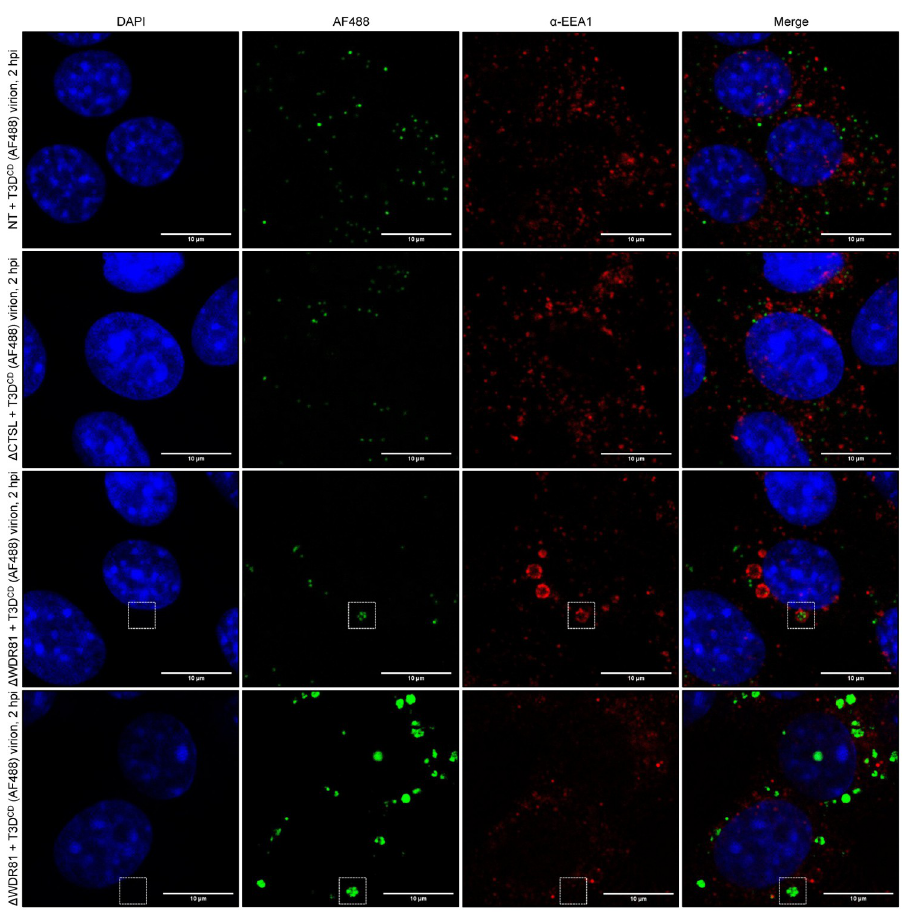
fixed, stained with an anti-EEA1 primary antibody and with DAPI, mounted, and imaged by confocal microscopy. The images were obtained using a X63 oil-immersion objective and processed using ImageJ software [42]. The DAPI signal is false colored in blue, the AF488 signal is false colored in green, and the EEA1 signal is false colored in red. The white boxes highlight large virus puncta and/or EEA1 donut-shaped structures. The scale bars represent 10 μ m (n = 3 biological replicates; results from 1 representative experiment are